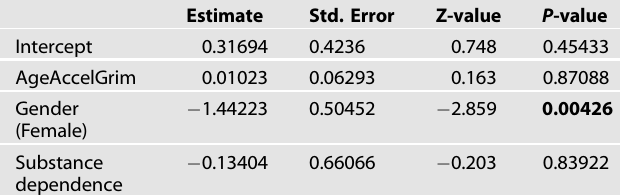
Table 2. Binomial logistic regressions contrasting severity of suicide attempt to Grim Age